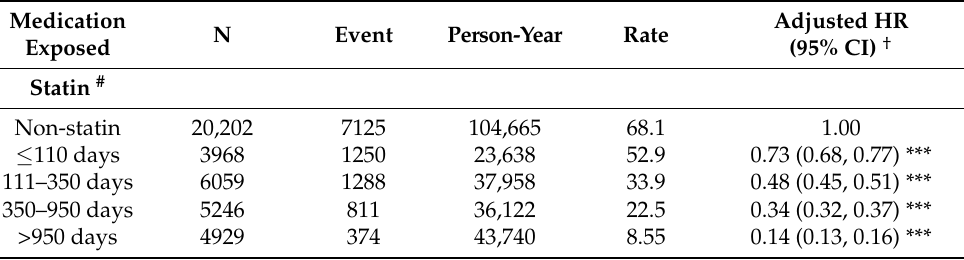
Rate, incidence rate per 1000 person-years. # Cumulative use days are partitioned into four segments by quartile. Adjusted HR † : multivariable analysis including age, sex, comorbidities, and medications. Abbreviations: CI, confidence interval; HR, hazard ratio. *** p < 0.001.